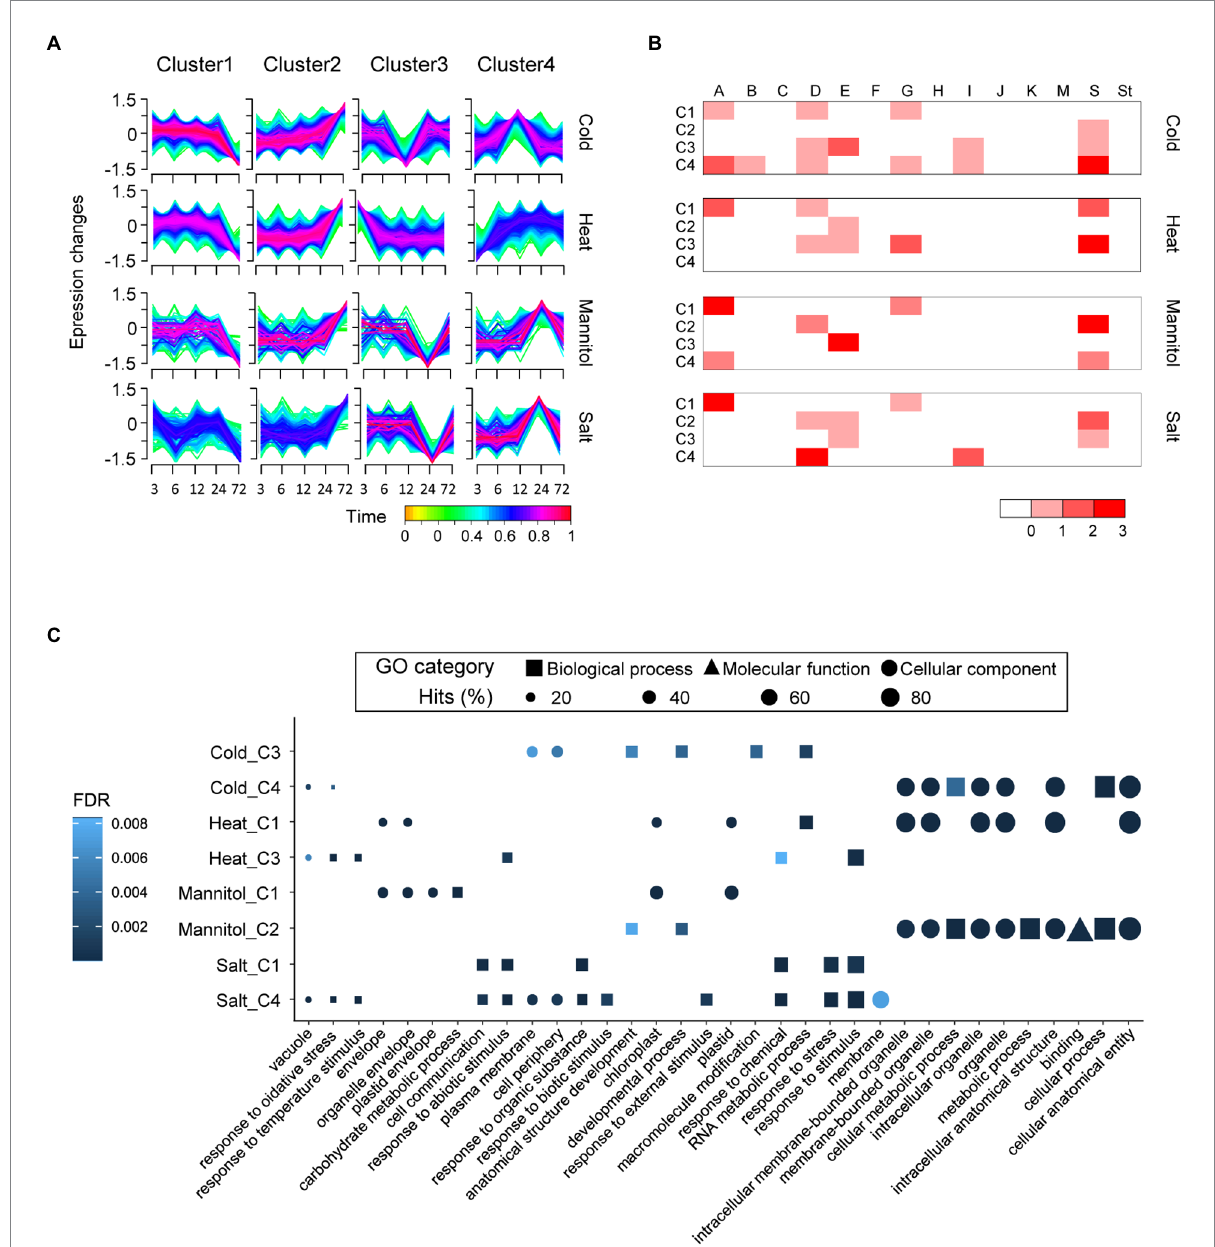
FIGURE 4 Transcriptome and gene ontology (GO) enrichment analyses of differentially expressed genes under four abiotic treatments in pepper ( Capsicum annuum ). (A) Expression patterns of whole pepper DEGs and bZIP DEGs during abiotic stress are displayed as four clusters for each abiotic stress. (B) Heatmap depicts the number of bZIP DEGs in each subgroup. The scale colors on the bottom right side of the heat map display the number of genes. (C) The top five GO terms enriched in each major cluster are displayed in dot plots. Shapes represent the GO categories; shape sizes represent the GO term